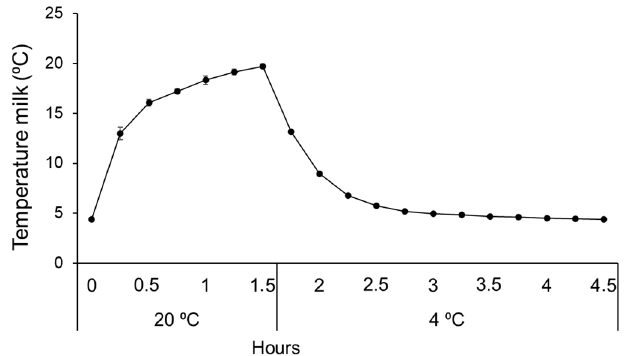
Figure 5. Temperature fluctuation in 40 mL UPM incubated at 4 °C, interrupted with incubation at 20 °C for 90 min. Error bars represent standard deviation.